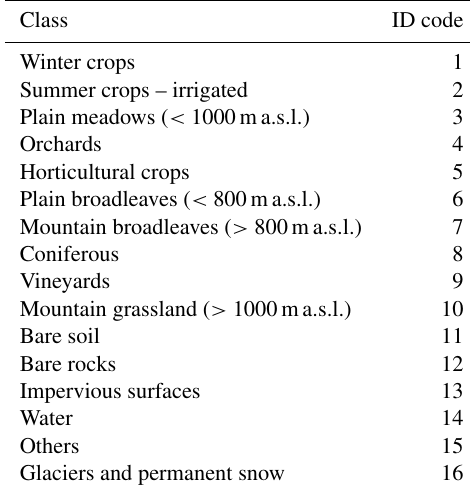
Table 2. Land cover